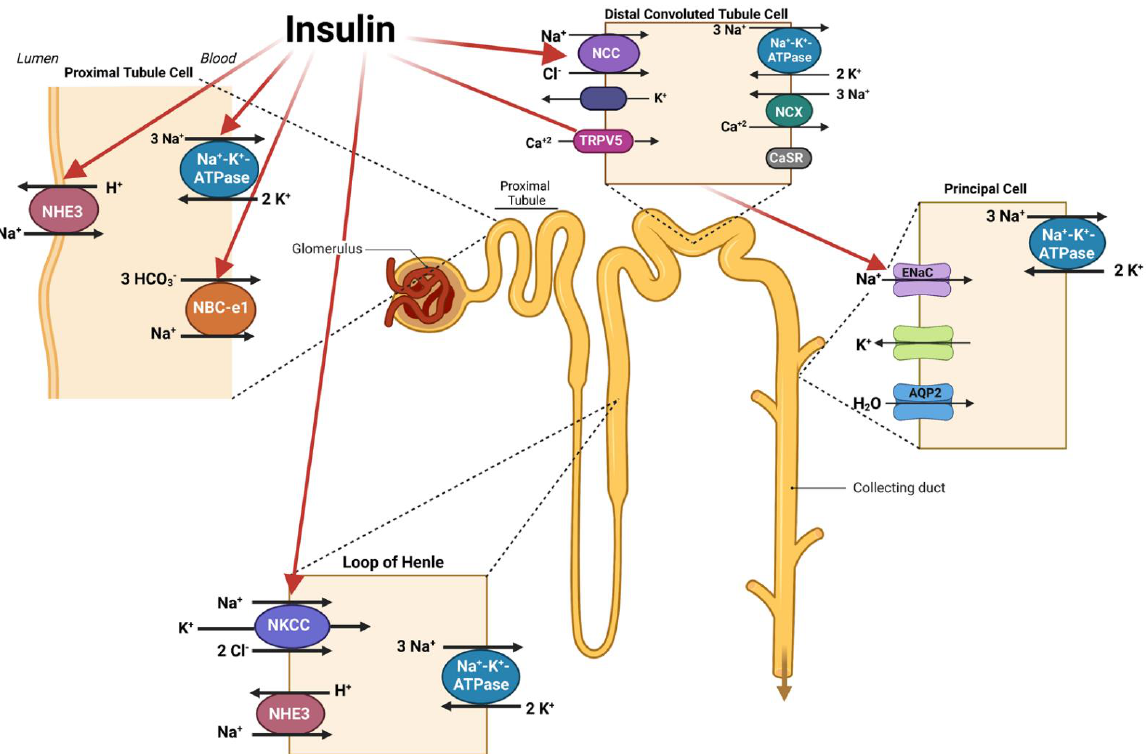
Figure 1. Schematic diagram depicting the stimulatory effect of insulin on salt transporters in the kidney tubules. The prevailing studies indicate that activity of multiple transporters in various nephron segments are upregulated in response to insulin and contribute to the enhanced transport of sodium. Created with Biorender.